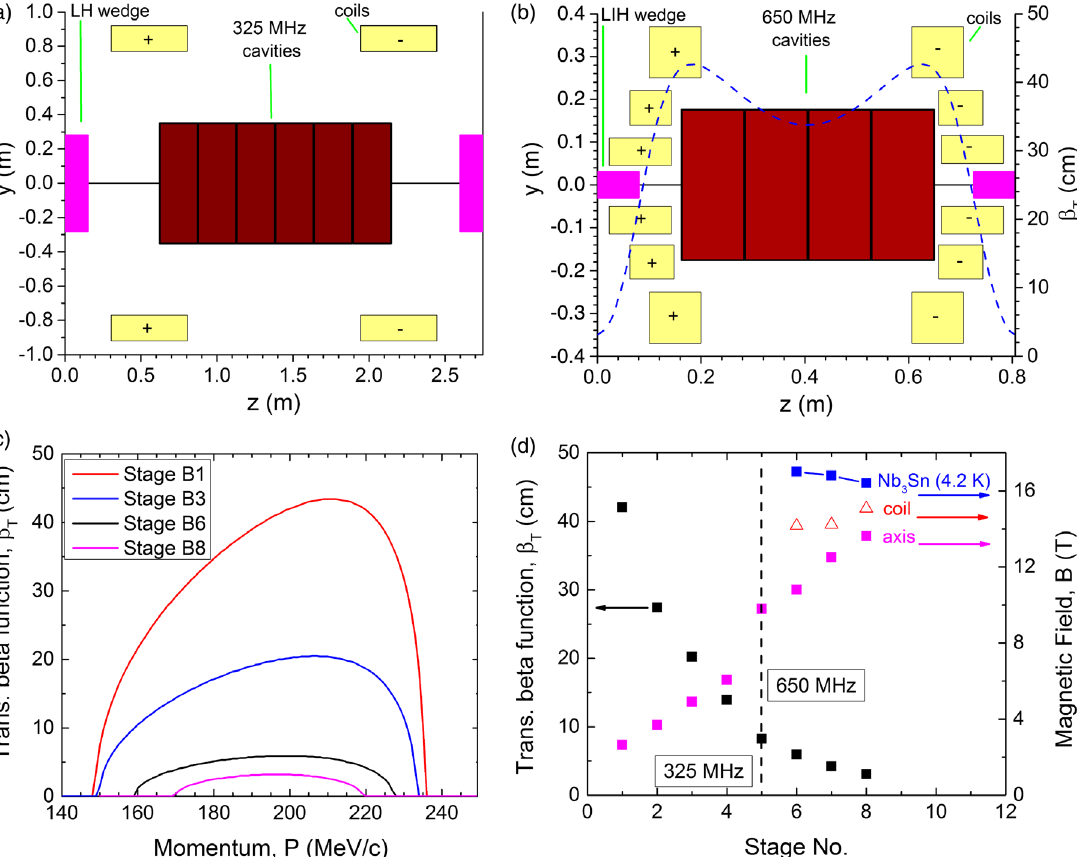
FIG. 5. Lattice characteristics of the rectilinear 6D cooling channel after bunch recombination: (a) side view of one cell of the first stage (stage B1); (b) side view of one cell of the last stage (stage B8). The dashed curve shows the beta function versus z in the cell at 200 MeV =c ; (c) beta function versus momentum; (d) beta function at the absorber center (at 200 MeV =c ) and peak-on-axis magnetic field for all stages. The triangles depict the maximum field in the coil, while the squares show the maximum allowable field at the used coil current density, assuming an Nb 3 Sn conductor. The used current densities are 185 A = mm 2 (stage B6), 198 A = mm 2 (stage B7) and 220 A = mm 2 (stage B8). The tilts of solenoids are not